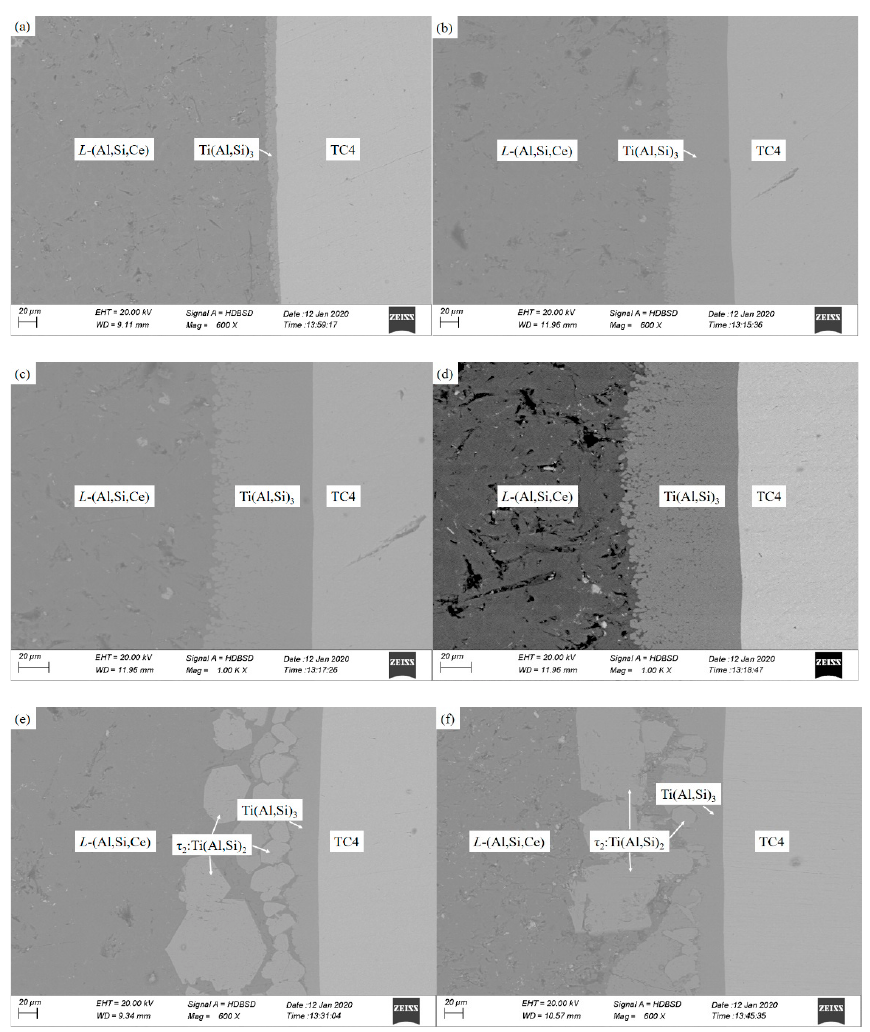
Figure 2. The microstructure of the Ce-added coating at different hot infiltration times, ( a ) 20 min; ( b ) 30 min; ( c ) 40 min; ( d ) 50 min; ( e ) 60 min; ( f ) 80